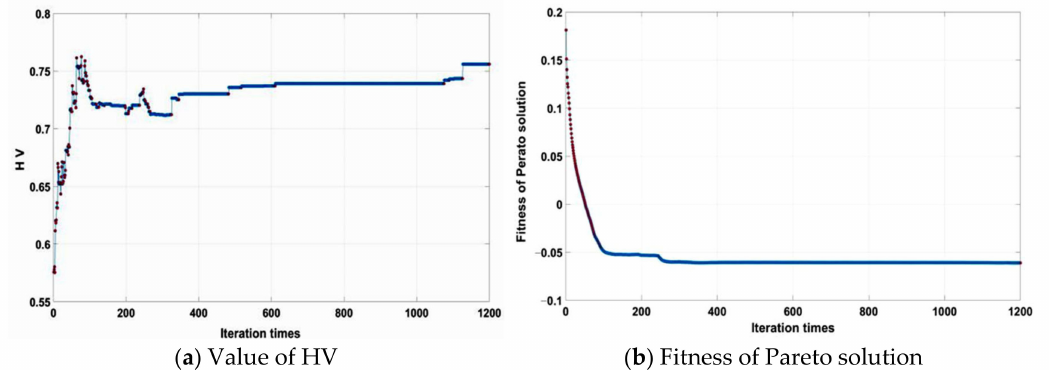
Figure 17. HV index and fitness change with iteration